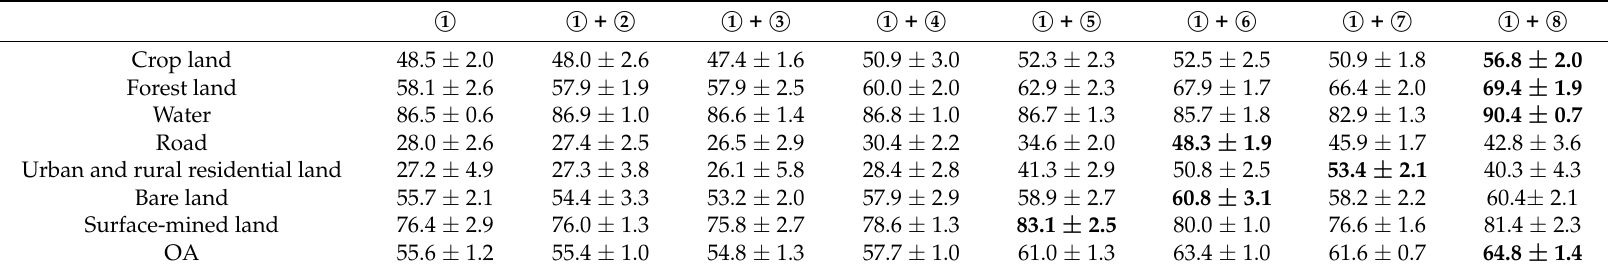
Table 7. The F1-measure and overall accuracy (OA) (%) for land cover classification in complex surface-mined landscapes using spectral bands and different types of feature sets: 1 (cid:13) : spectral bands; 2 (cid:13) : vegetation index; 3 (cid:13) : PC bands; 4 (cid:13) : the Gaussian low-pass filters; 5 (cid:13) : the mean filters; 6 (cid:13) : the standard deviation filters; 7 (cid:13) : texture measures; and 8 (cid:13) : topographic variables. The bold values represent the best F1-measures and OA values. The accuracies with standard deviation were averaged on 10